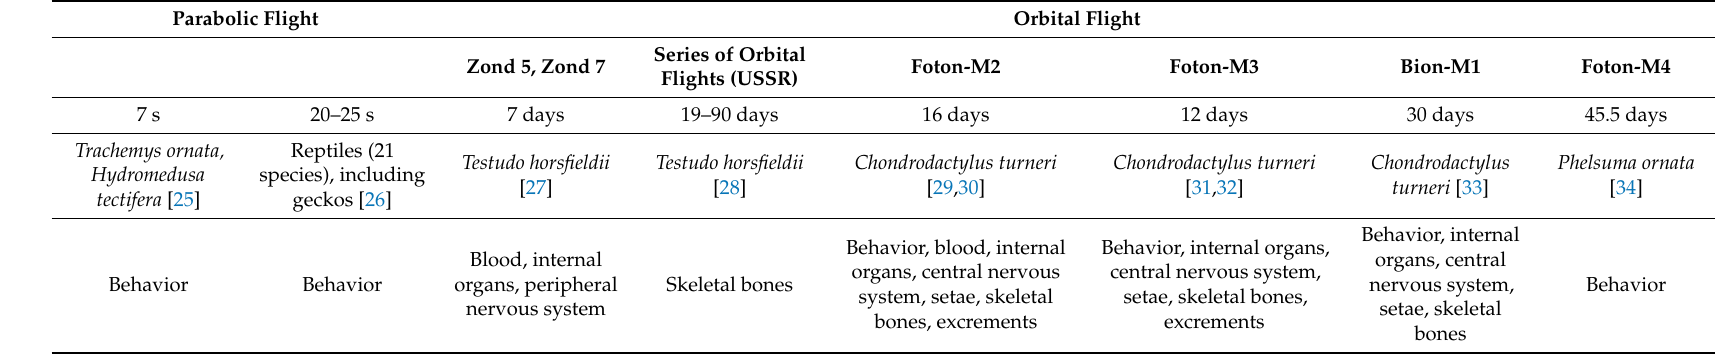
Table 1. The main orbital and parabolic flight experiments with